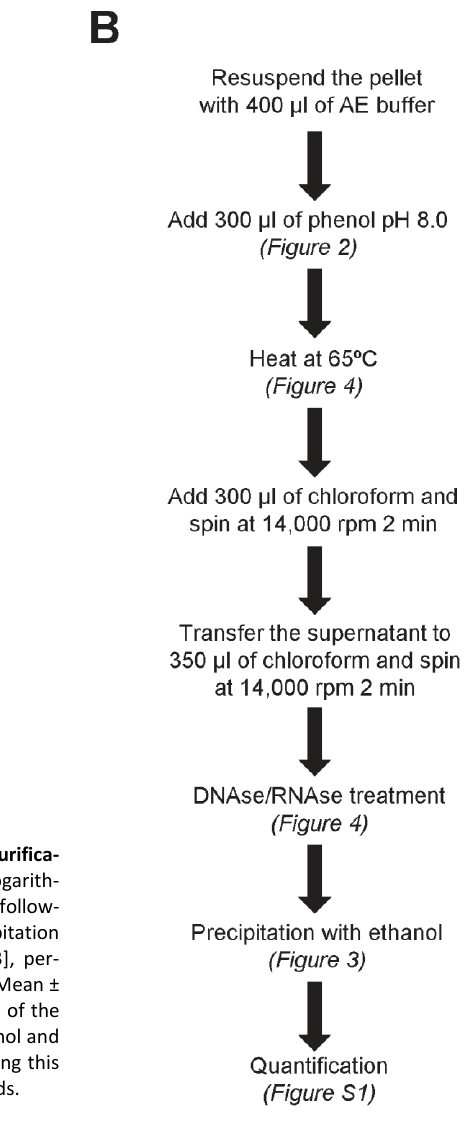
OPEN ACCESS | www.microbialcell.com